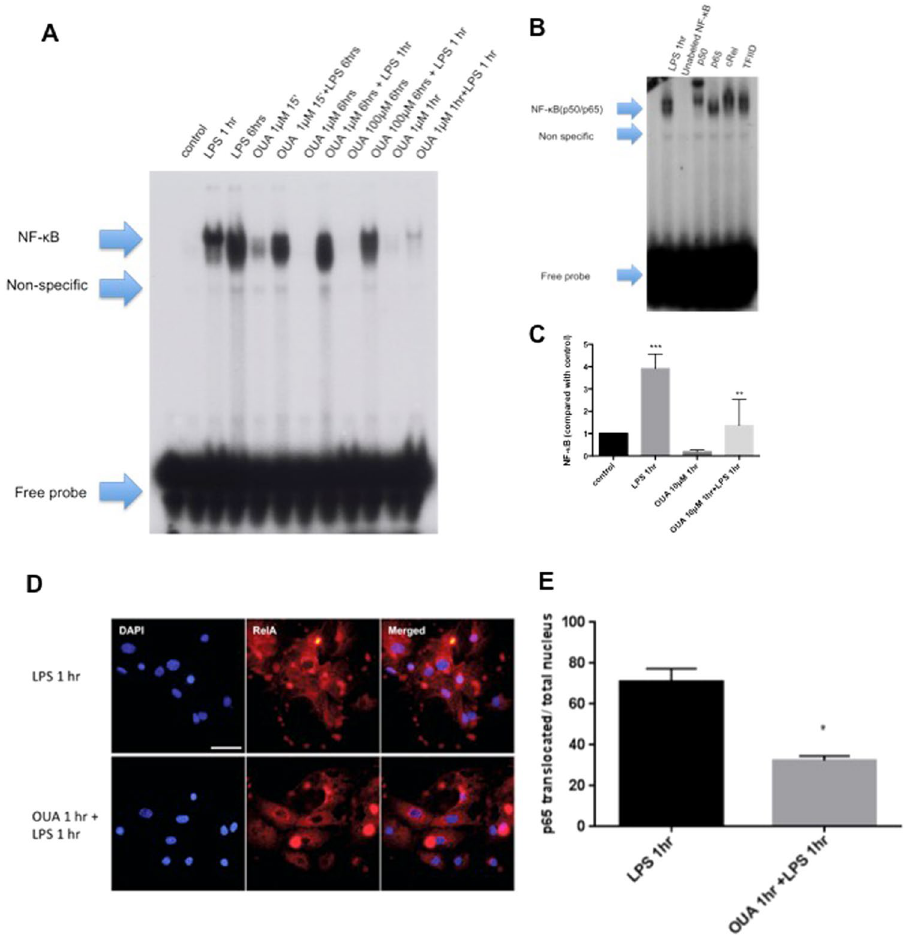
Figure 3. OUA can decrease the NF- κ B activity induced by LPS in nuclear fraction. ( A ) After treatment with the given concentrations and time, protein from the cells was extracted, and the nuclear fraction was used to perform the EMSA assay to measure NF-kB activity. ( B ) A super-shift was also performed to show which NF- κ B subunits are involved in this phenomenon. ( C ) Densitometric analysis comparing control NF- κ B activity with 1 µ g/mL LPS treatment for 1 hour and 10 µ M OUA for 1 hour (n = 4). *** (p < 0.05 vs control and 10 µ M OUA for 1 hour) and ** 10 μ M OUA + LPS 1 hour (p < 0.05 vs LPS for 1 hour). ( D ) Glial cells were treated for 1 hour with LPS followed by 10 μ M OUA treatment for 1 hour and 6 hours and stained with RelA antibody and DAPI. ( E ) The RelA (p65)-positive nuclei were counted and divided by the total number of nuclei, and the graph shows the comparison between the LPS group and for O + L group expressed by the ratio RelA (p65) translocated to the nucleus over the total amount of RelA (p65) (%) (n =